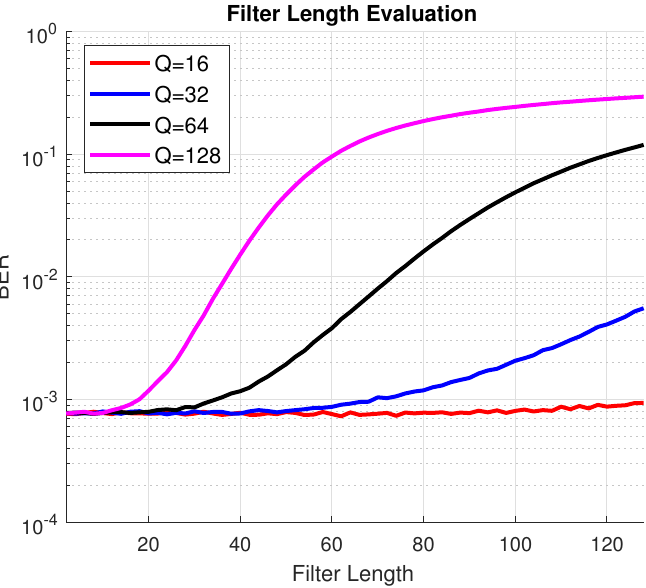
Figure 11. Filter length evaluation over AWGN